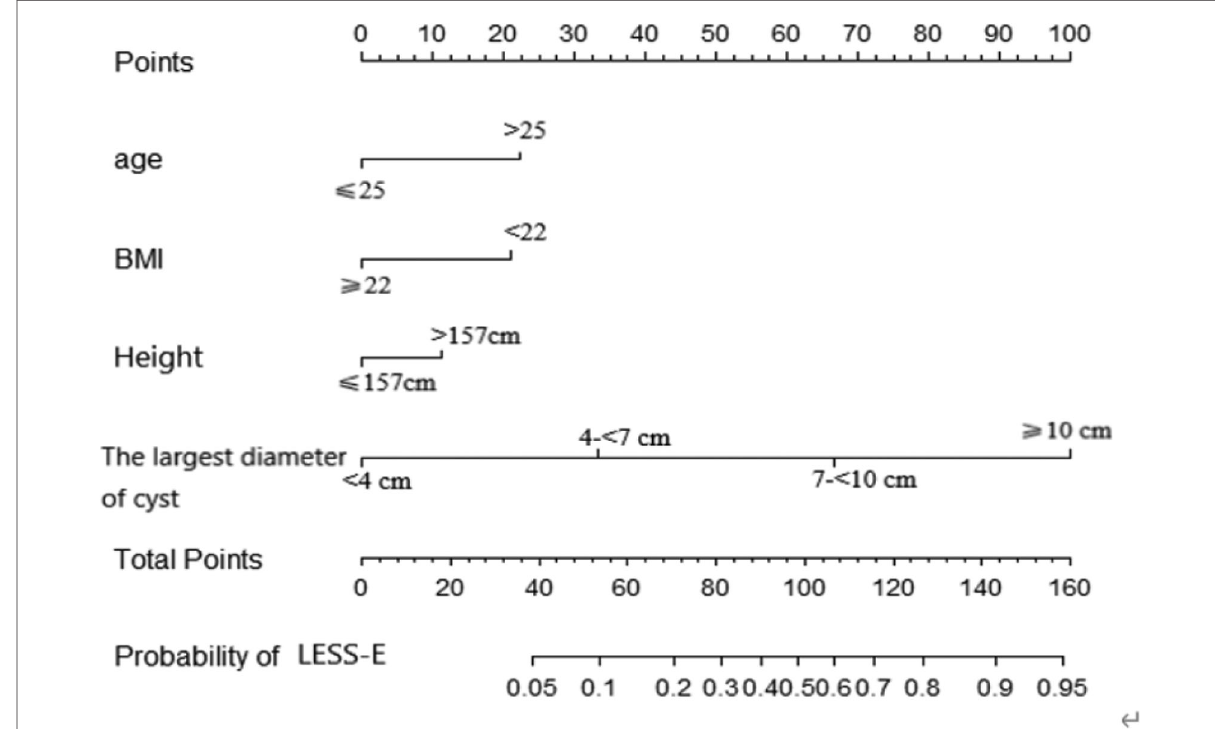
FIGURE 2 The proposed nomogram to predict the probability of the LESS-E approach. Points were assigned for age, BMI, height and largest diameter of the cyst by drawing a line upward from the corresponding values to the “ points ” line. The sum of these four points, plotted on the “ Total points ” line, corresponds to the probability of the LESS-E approach.